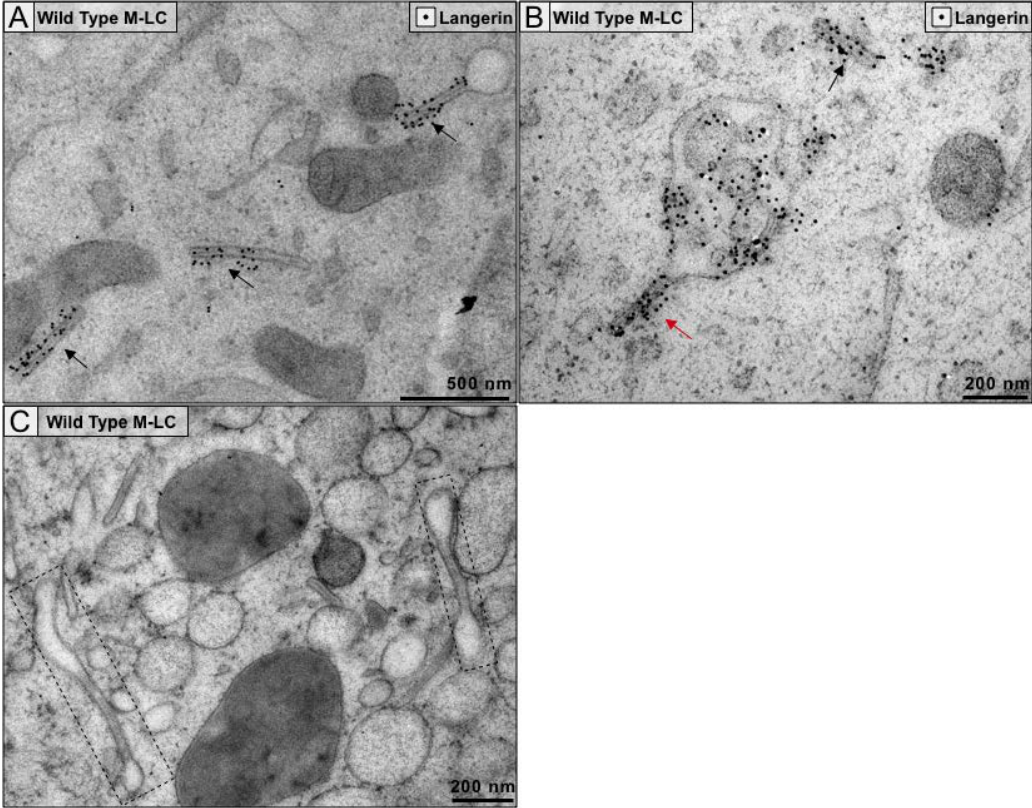
Figure 1. Birbeck granules in wild type MUTZ-derived langerhans cells (LC) (M-LC) have abundant langerin labeling localized to the cytomembrane sandwiching structure (CMS). ( A ) 10 nm gold particles (black arrows) show langerin labeling is localized to the CMS in Birbeck granules (BG); ( B ) Langerin labeling is contained within a cytoplasmic multivesicular endosome, likely a recycling endosome. Here, a BG CMS through langerin zippering from these stores is visible (red arrow); ( C ) BG structures containing multiple vesicular lobes on each end of the CMS (boxes). Images are representative of at least three biological replicates with a minimum of three grids each.